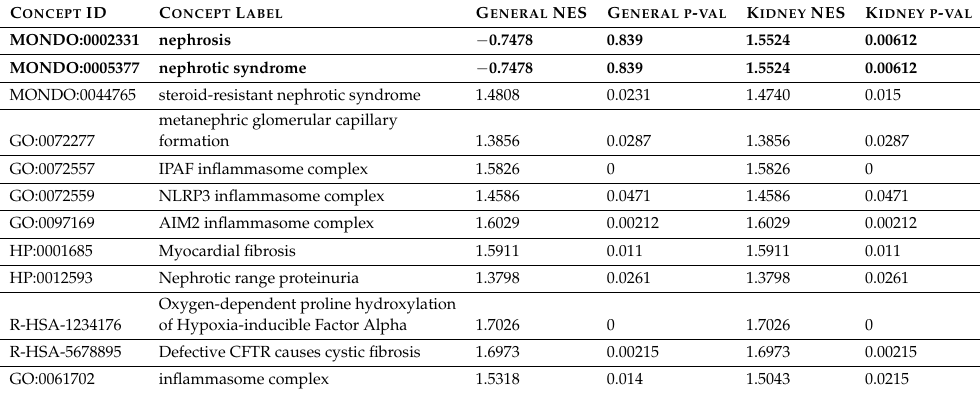
Table 3. Comparison of concept enrichment score between gene sets derived from the general KG vs. gene sets derive from the kidney KG. The first two rows correspond to concepts that are highly relevant to the nephrosclerosis study and only become statistically significant when using the kidney